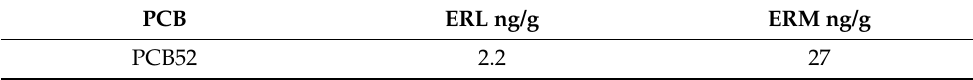
Table 8. USEPA Environmental Quality Standards for PCBs in sediments (ng/g).